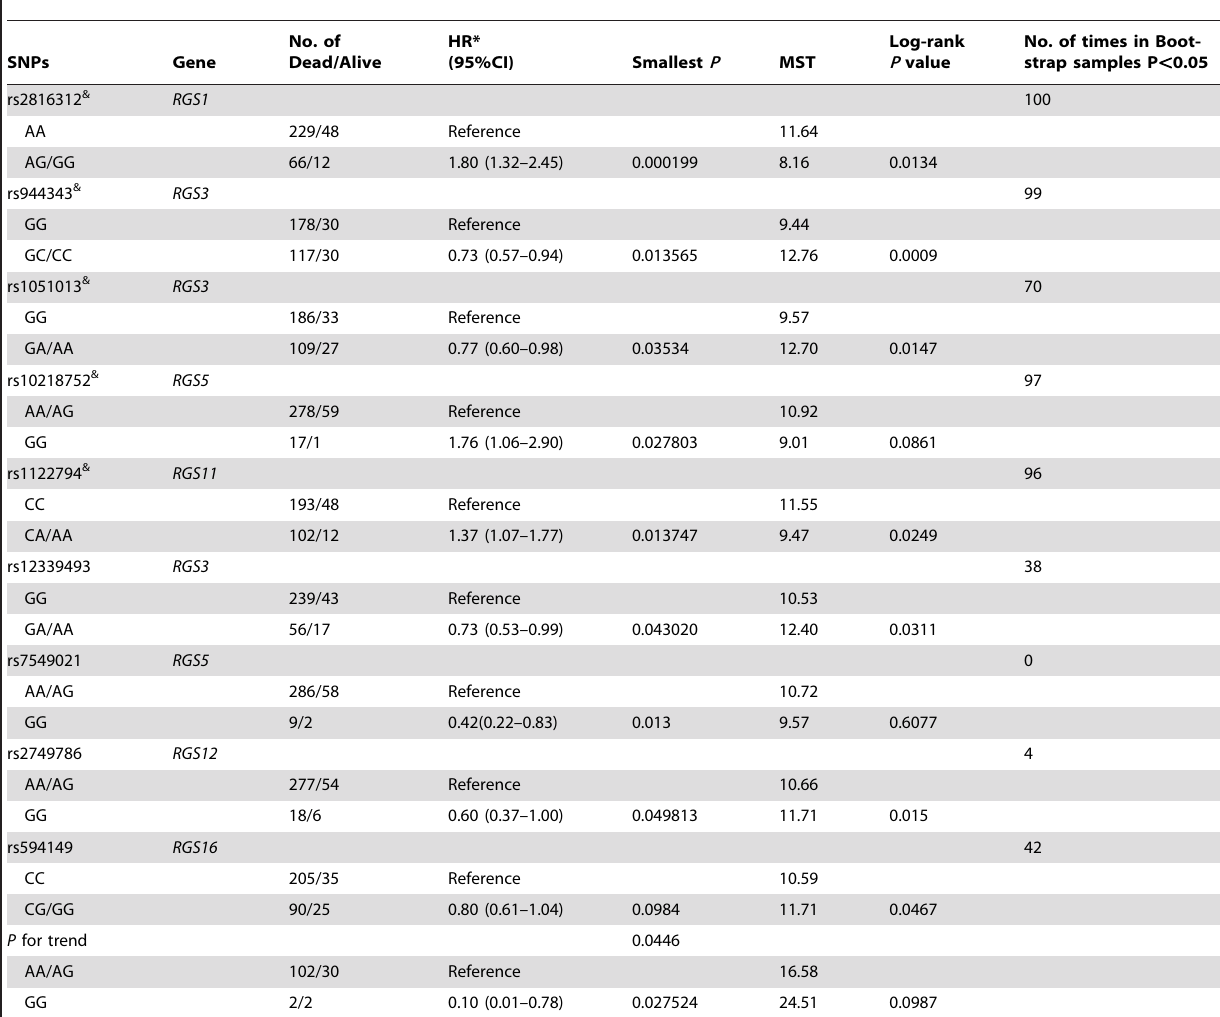
Table 3. Stratified analysis by treatment modality: Chemotherapy.